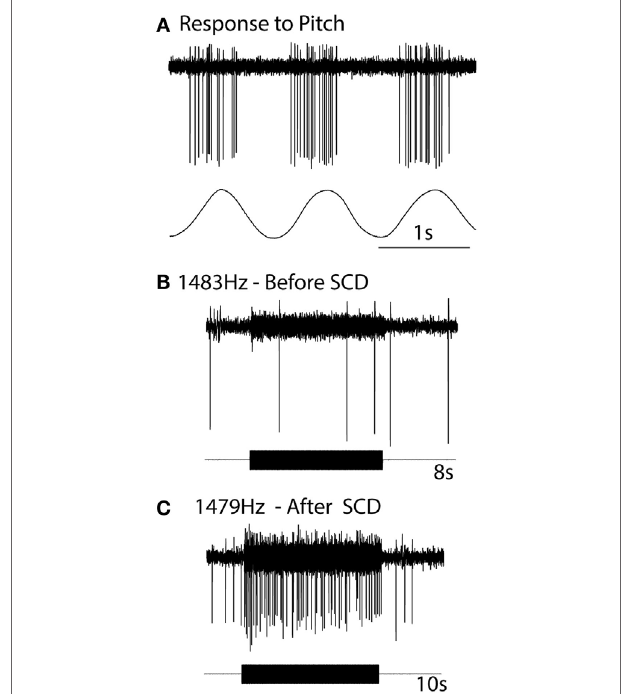
FigURe 9 | The response of the one anterior canal neuron to high-frequency air-conducted sound (ACS), before and after a small dehiscence in the bony wall of the anterior canal. (A) The response of the neuron to pitch angular acceleration identifies the neuron as being an anterior canal afferent. (B) Before semicircular canal dehiscence (SCD), an 8 s burst of 1,483 Hz ACS has no effect on the neural response. (C) After SCD, a 10 s burst of an ACS of 1,479 Hz causes strong activation. Resealing the SCD causes that enhanced response to disappear. Reprinted by permission from Springer Nature, Curthoys (81), ©